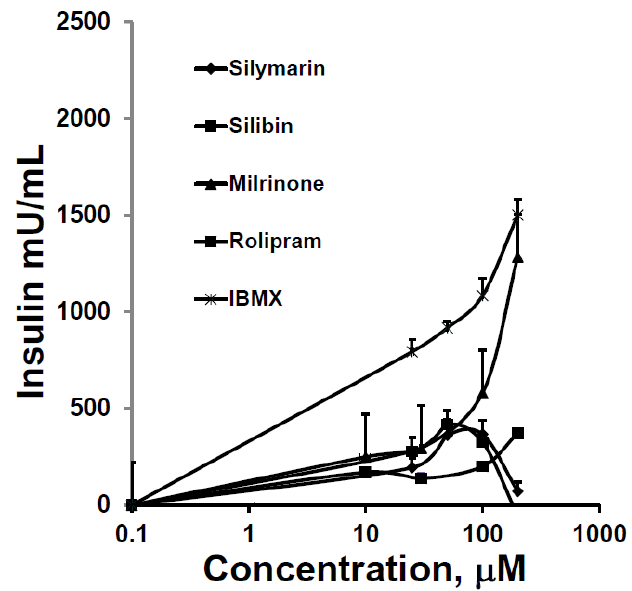
Figure 5. Augmentation of GSIS over baseline from HIT-T15 cells in static incubations containing 11.1 mM glucose over 2 h. A series of increasing concentrations of phosphodiesterase inhibitors was compared. The first evidence for the augmentation of GSIS occurred at a concentration of 20 µ M for all drugs, and maximum responses occurred at 100 µ M, except for milrinone and 3-isobutyl-1-methylxanthine (IBMX), whose augmentation effects continued to rise. Data = mean ± SE; experiments performed in